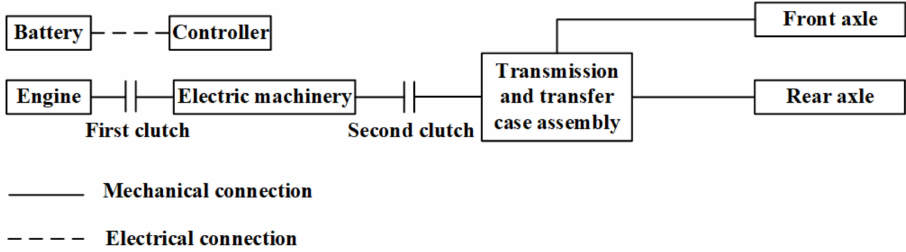
Figure 1. Schematic diagram of drive system of